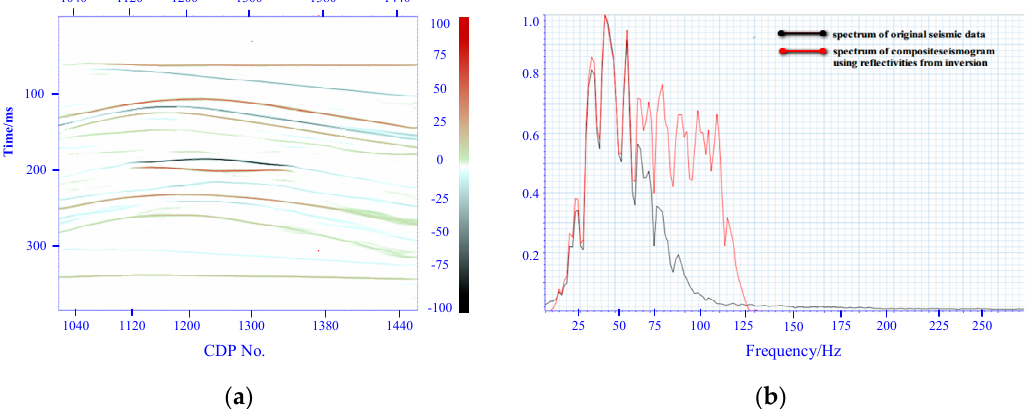
Figure 6. ( a ) Inversion result; and ( b ) comparison of the amplitude spectrum of the reconstructed seismic record and original seismic record.